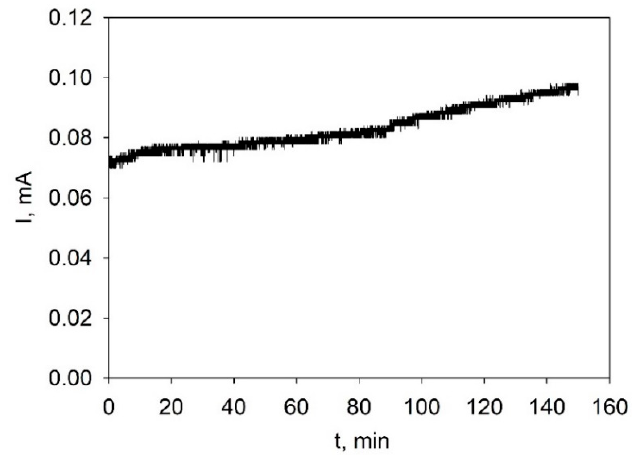
Figure 7. Dependence of the current on time during EPD at a constant electric field of 20 V/cm from a suspension with the addition of acetylacetone-YLO_iA_1.